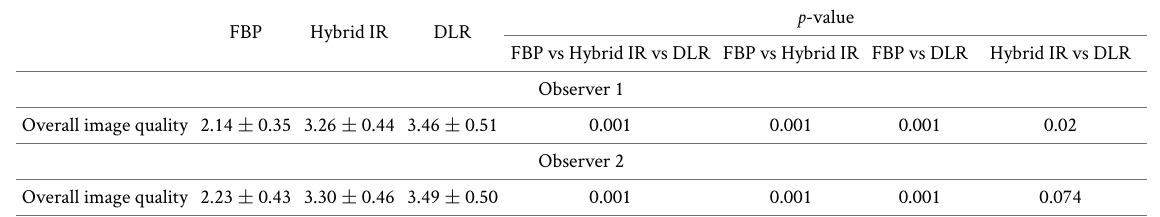
Table 3. The subjective image analysis